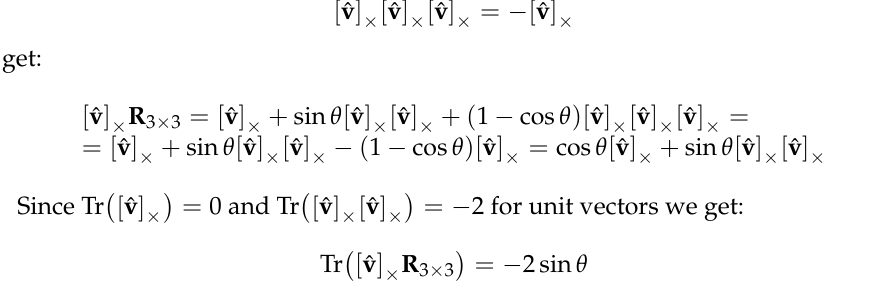
Figure 7. Using the ArUco module and the checkerboard calibration tool of OpenCV we get rotation matrices and translation vectors of each marker from the camera reference frame. Here we depict the quaternions q 1 and q 2 representing the rotation of two ArUco markers and the quaternion q g from the checkerboard representing the ground floor. q 1